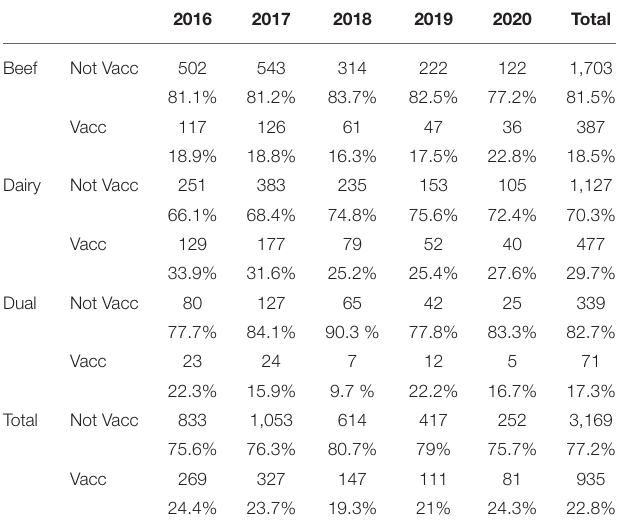
TABLE 6 | Number (%) of herds applying BVD vaccination by herd type and